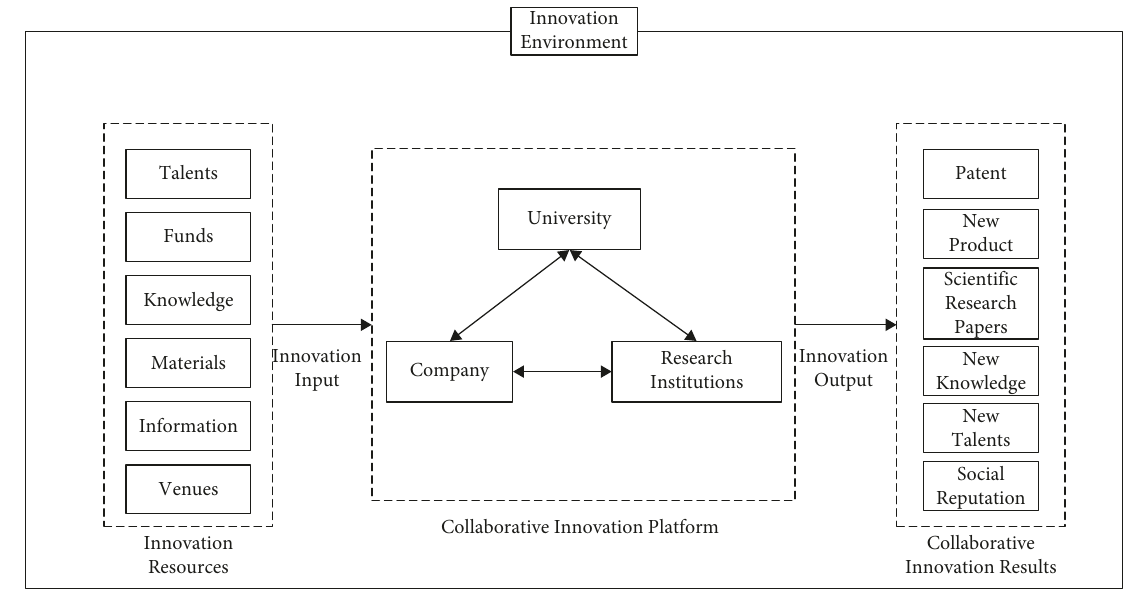
Figure 1: The structure of the equipment manufacturing IUR collaborative innovation